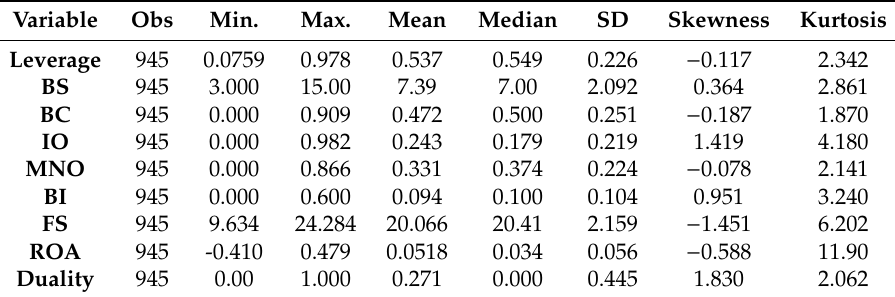
Table 2. Descriptive